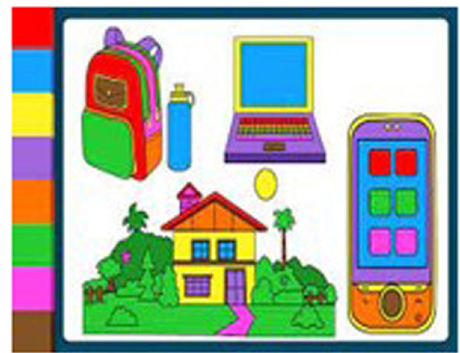
Fig. 3 G2 ’ s original visual representation. This fi gure shows how EFL learners perceive traditional learning methodologies.